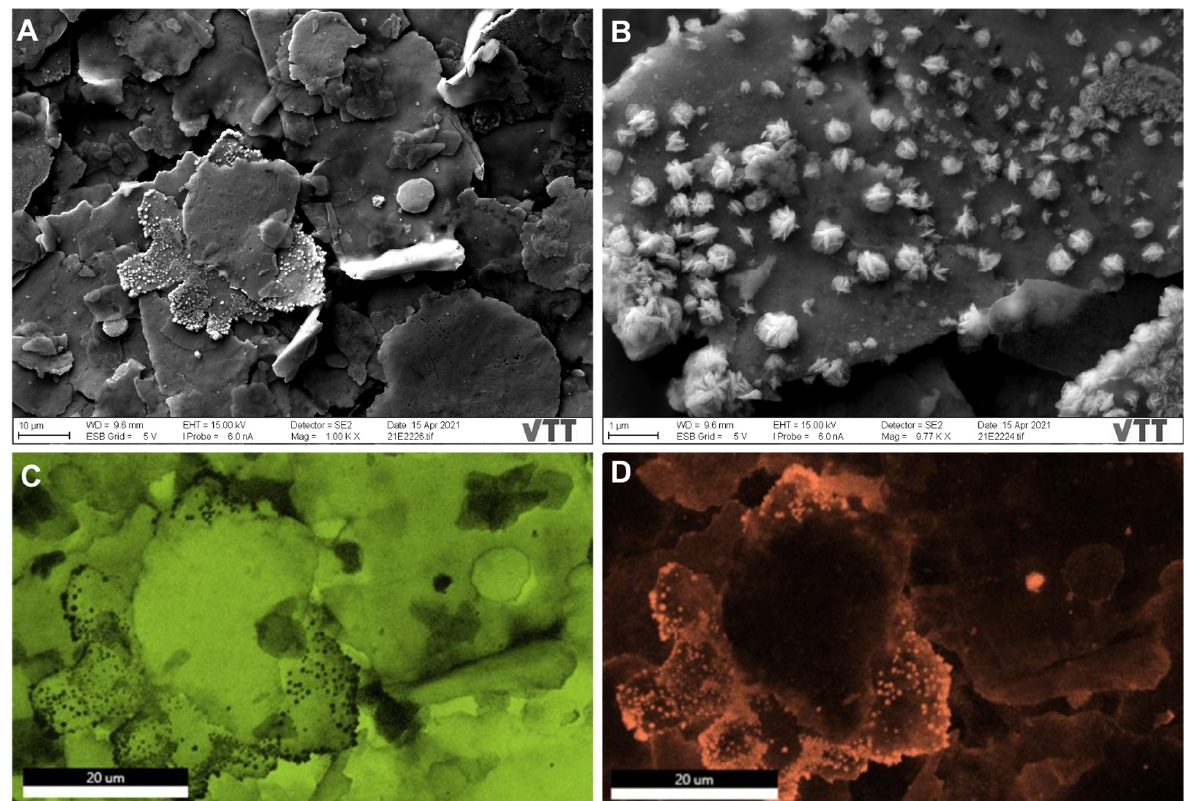
Figure 3. SEM images and EDX mapping of sample B. ( A ) SEM image of morphological irregular copper flakes. ( B ) SEM image of star-shaped Ag NPs decorating the copper flakes that were more branching than sample A. ( C ) Mapped image of morphological irregular copper flakes denoted in green. ( D ) Mapped image of star-shaped Ag NPs decorating the copper flakes denoted in orange.